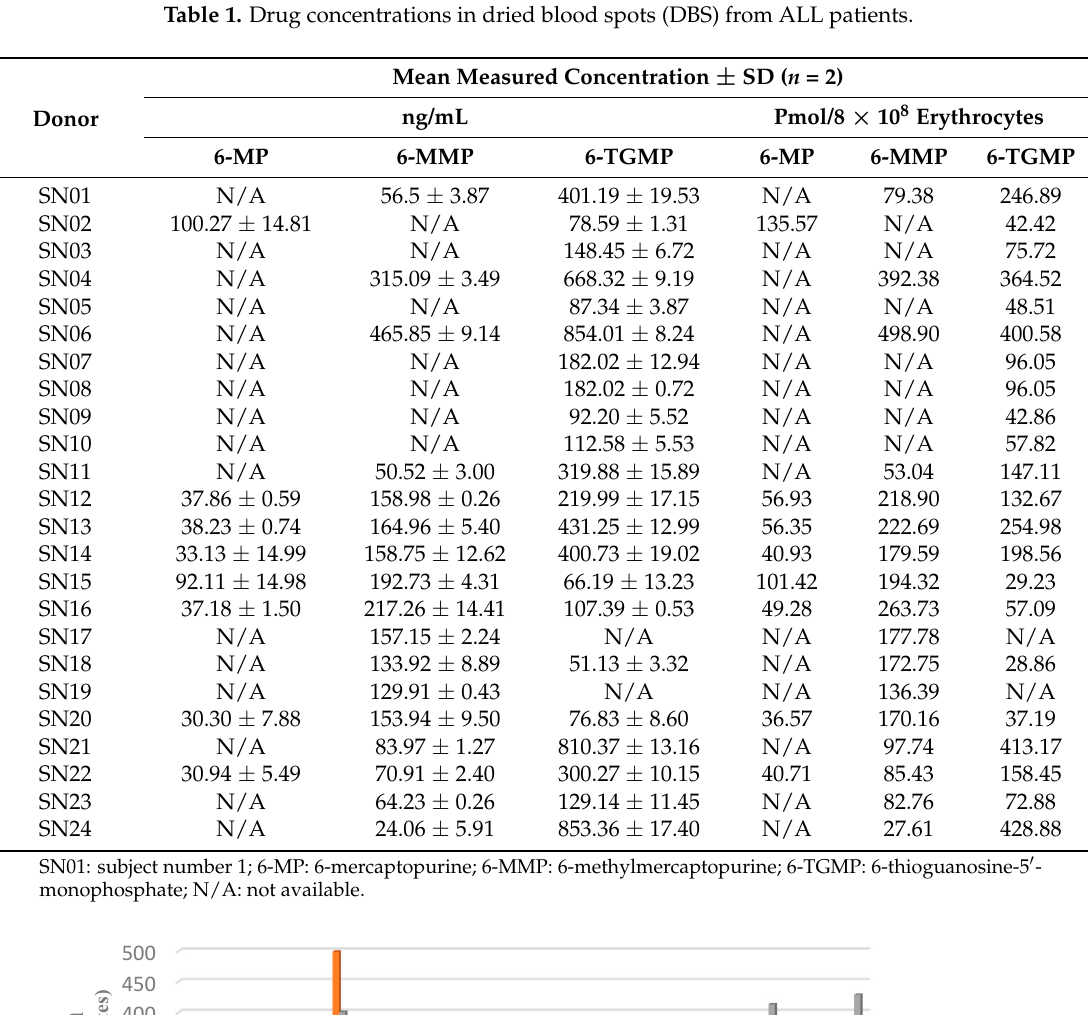
050100150200250300350400450500